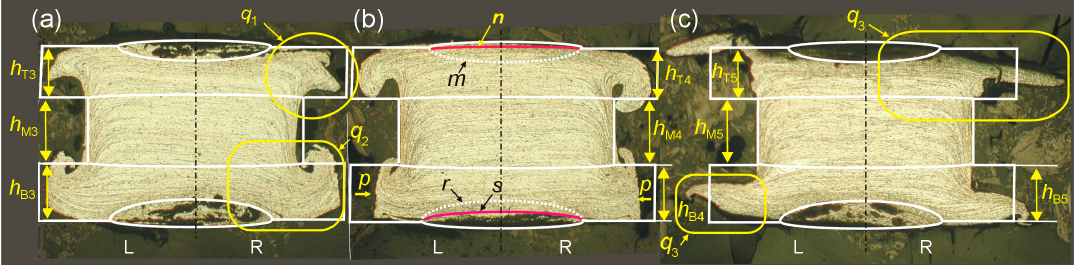
Figure 6. The metallographic cross-sections of the samples: ( a ) sample S3; ( b ) sample S4; and ( c ) sample S5.